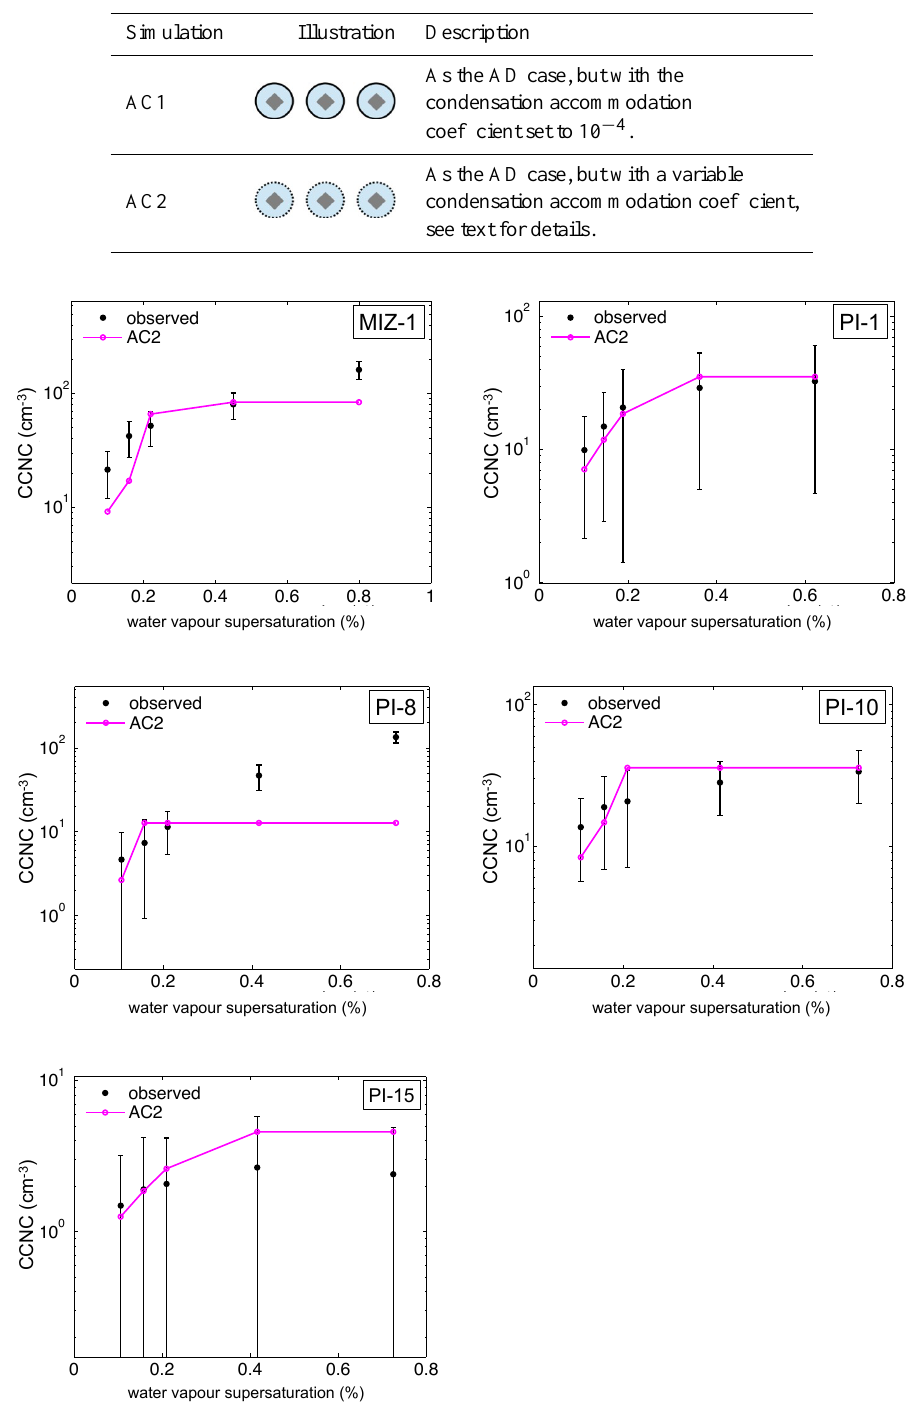
Figure 12. Observed and simulated CCNC for samples MIZ-1, PI-1, PI-8, PI-10 and PI-15, ranging from 0.1 to 0.8% water vapour SS. Error bars represent 1 standard deviation. AC2 correspond to the assumption AD (see Table 2), with a variable condensation accommodation